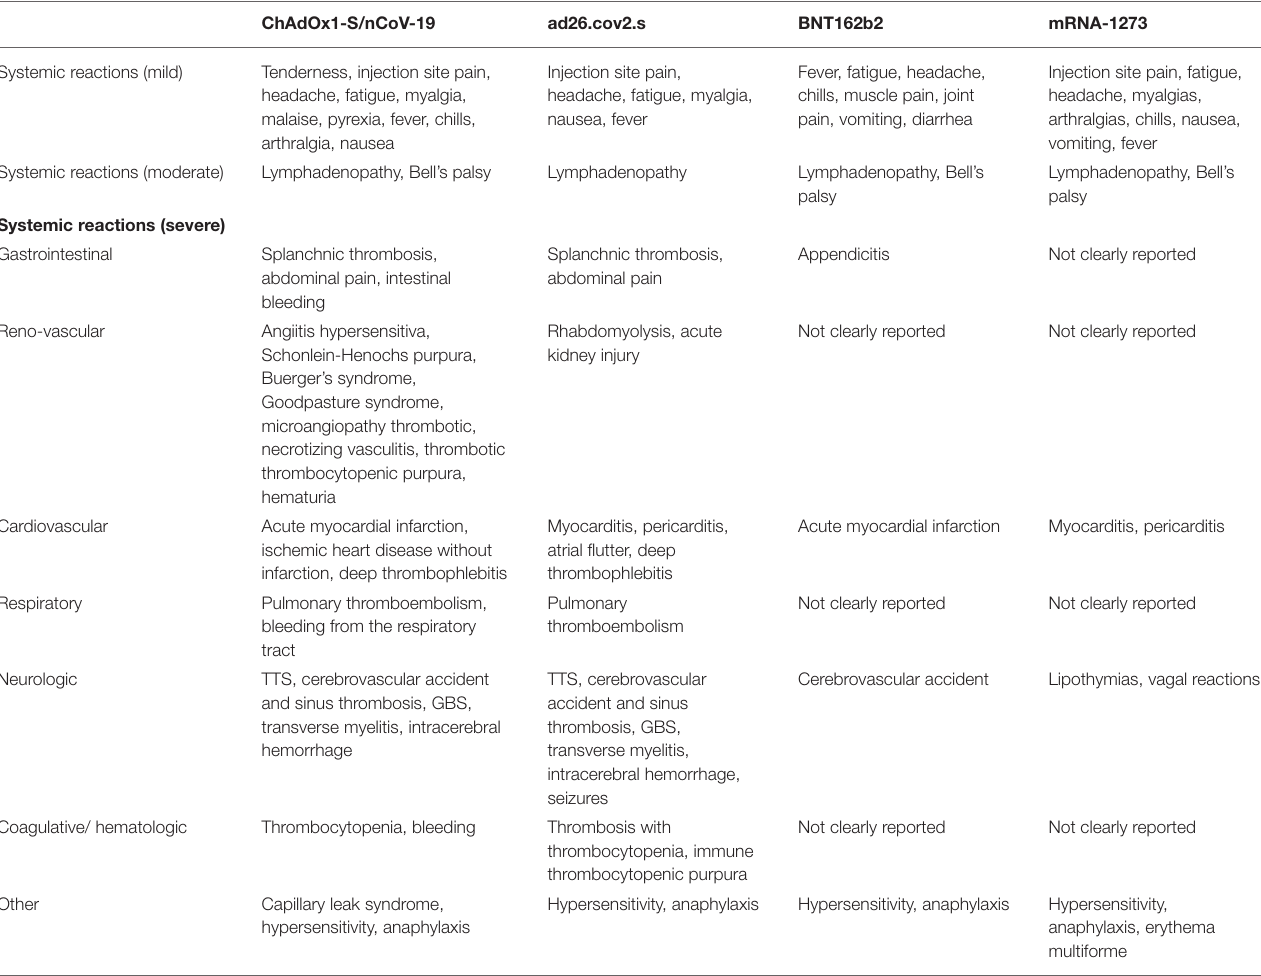
TABLE 2 | Reported systemic manifestations of COVID-19